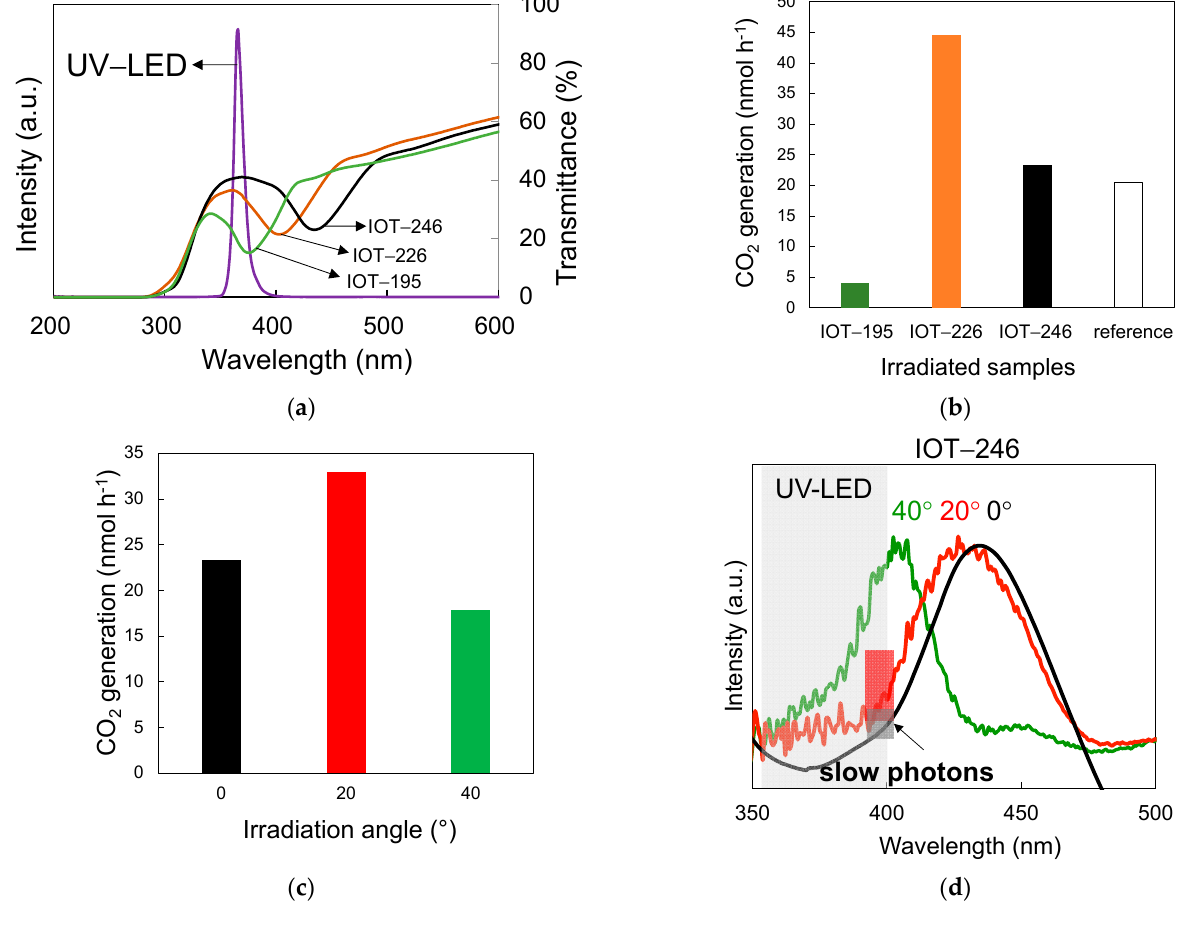
Figure 7. ( a ) Transmittance spectra of IOT samples and UV-LED emission peak; ( b ) the photocatalytic activity of IOT and reference (no PC) samples under irradiation at 0° angle; ( c ) the photocatalytic activity of IOT-246 sample under irradiation at different angles: 0°, 20°, and 40°; ( d ) extinction spectra of IOT-246 under different irradiation angle (0°, 20° and 40°) and UV-LED emission peak. The orange and blue squares represent the estimated slow photon effects for IOT-246 sample irradiated at 0° and 20°.